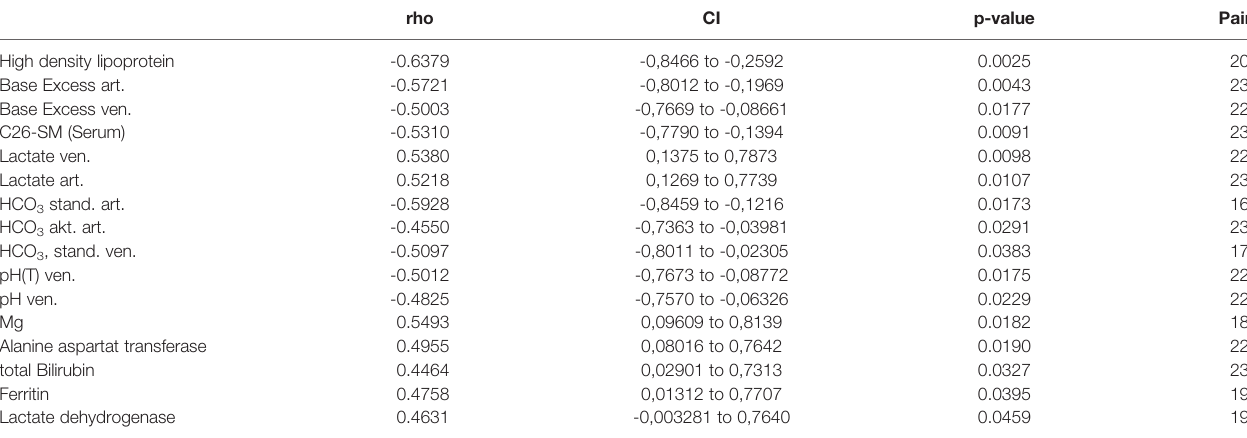
TABLE 4 | Correlational analysis of ASM-activity with clinical and laboratory data. rho CI p-value Pairs High density